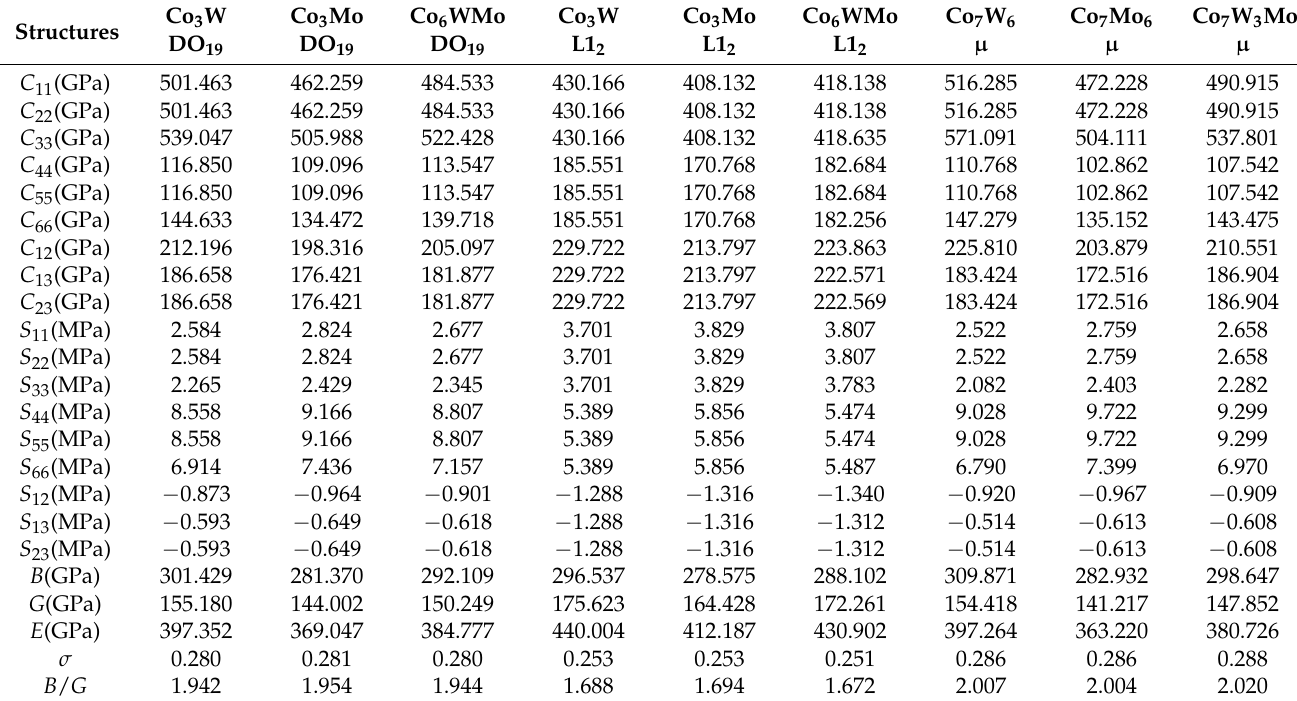
Table 2. The calculated elastic properties of the Co 3 X (DO 19 and L1 2 ) and Co 7 X 6